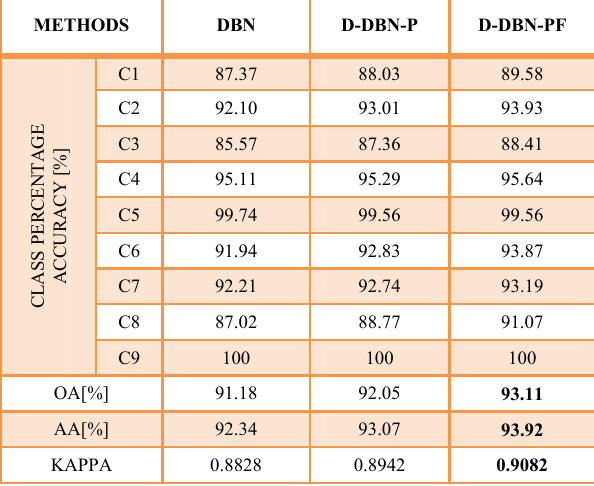
Table 2 Classification accuracies of DBN, D-DBN-P and D-DBN-PF over Pavia University data set.